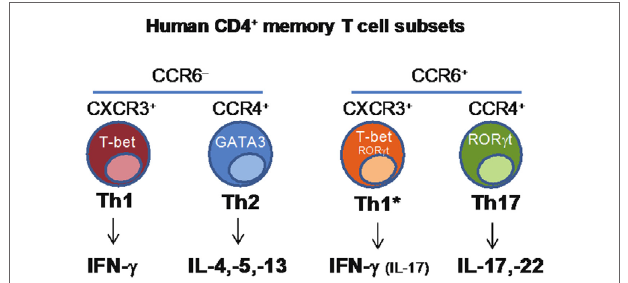
FiGURe 2 | Identification of human CD4 + memory T-cell subsets based on the differential expression of chemokine